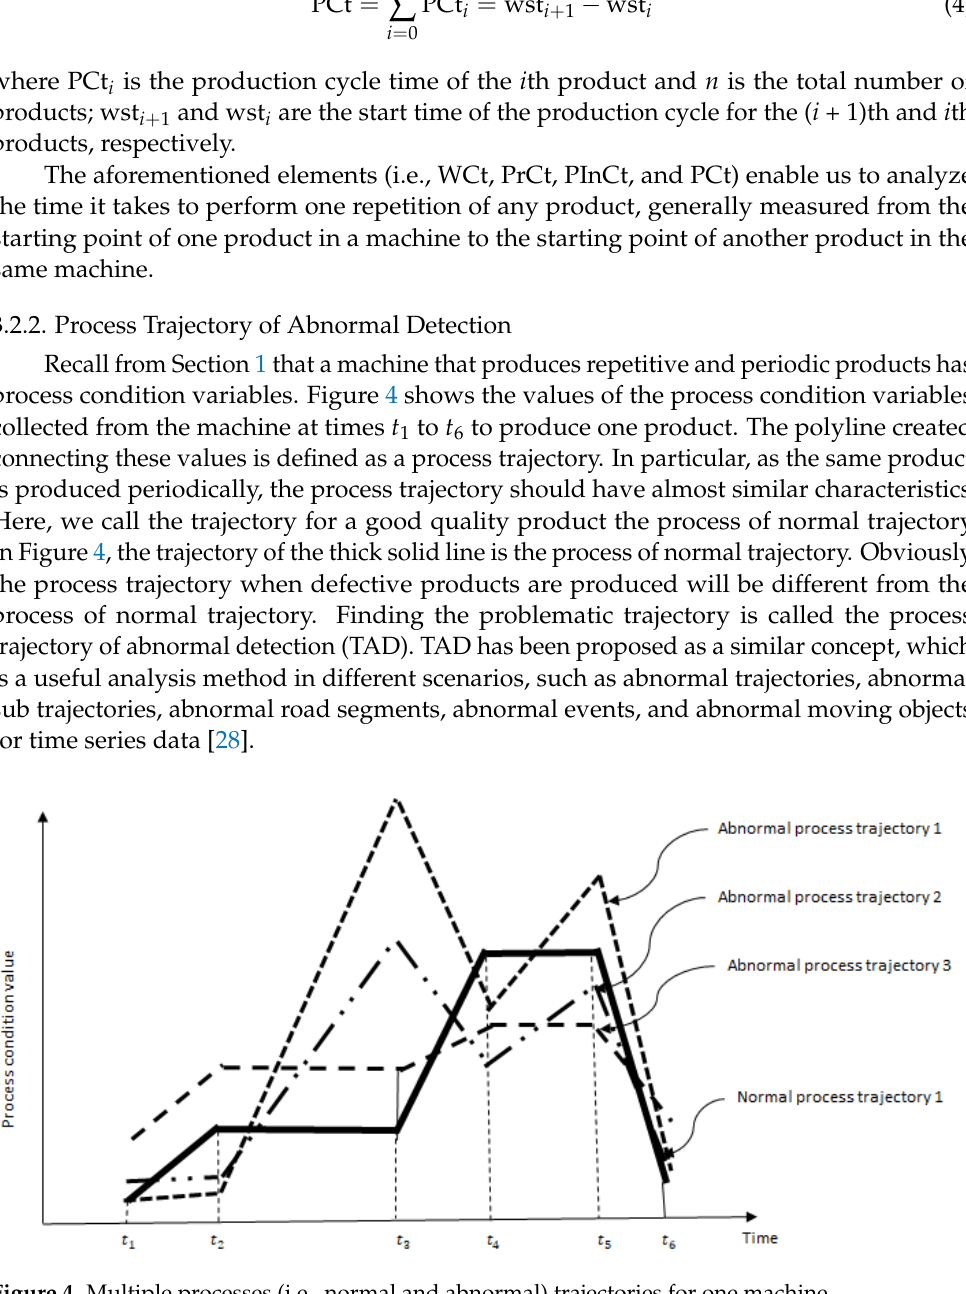
Figure 4. Multiple processes (i.e., normal and abnormal) trajectories for one machine.